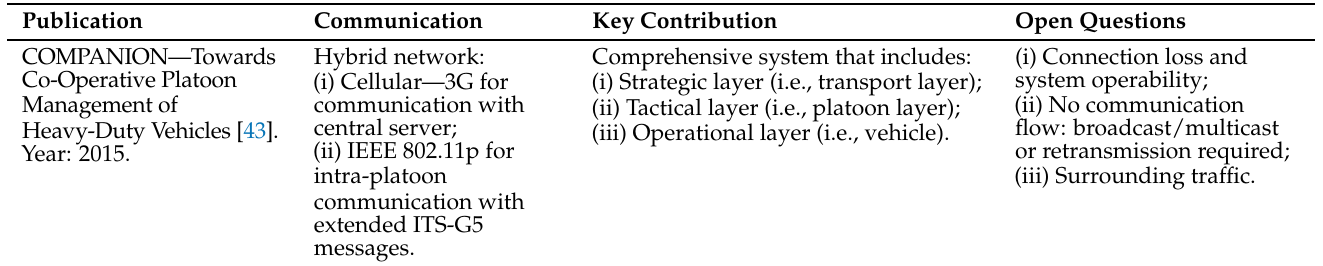
Table 3. Recent selected publications on different layers: used communication technologies, key contributions and open questions. The latter could be addressed by Feudalistic Platooning